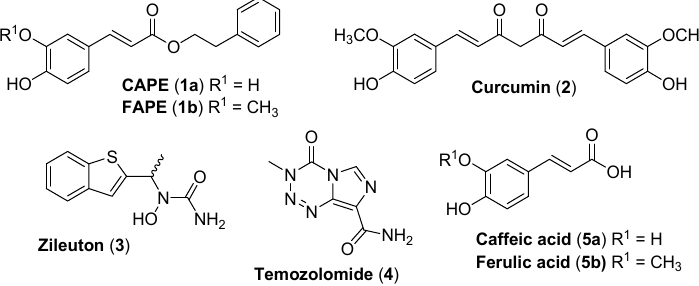
Figure 1. Structures of caffeic acid phenethyl ester (CAPE) ( 1a ), ferulic acid phenethyl ester (FAPE) ( 1b ), Curcumin ( 2 ), Zileuton ( 3 ), Temozolomide ( 4 ), Caffeic acid ( 5a ), and ferulic acid ( 5b ).